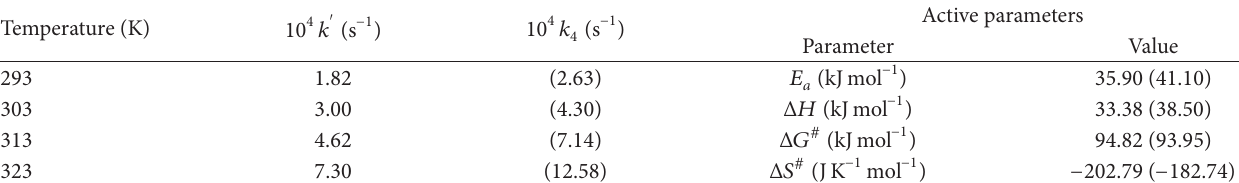
T 5: Effect of temperature on the reaction rate and activation parameters.